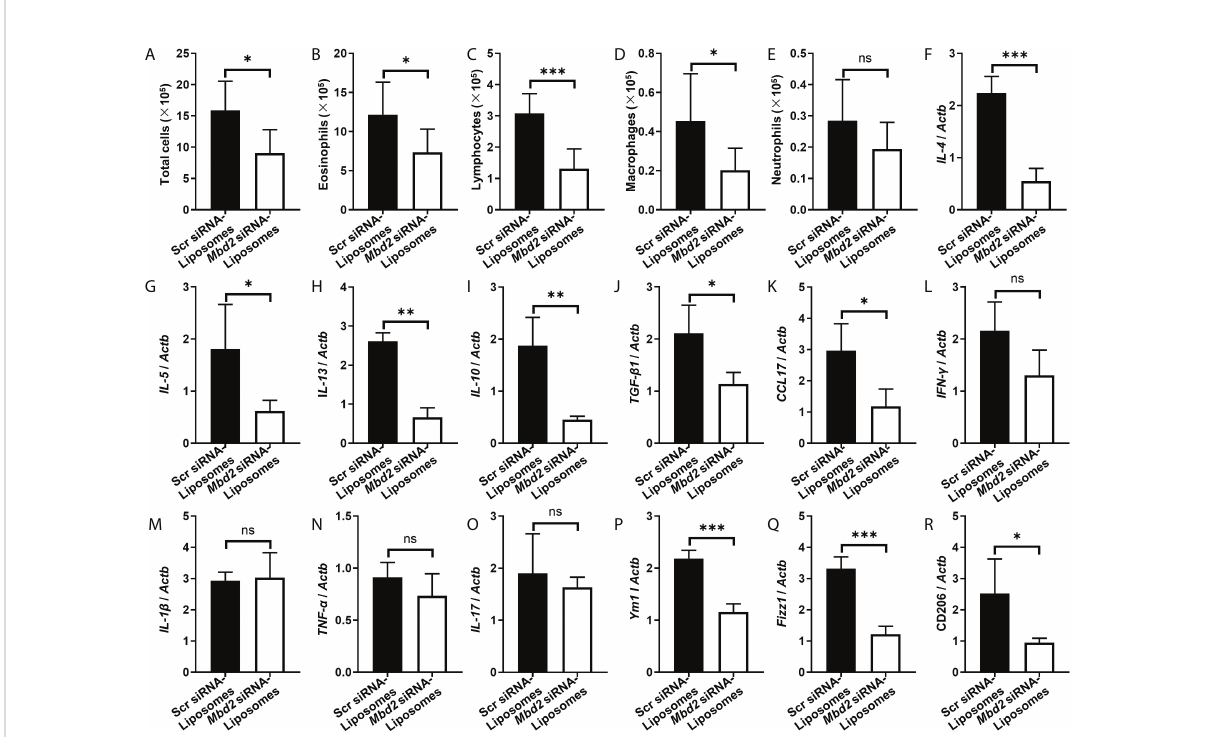
FIGURE 6 Comparison of the numbers of in fl ammatory cells and the levels of cytokines between scrambled siRNA or Mbd2 siRNA-loaded liposome- treated mice after 3 days of OVA challenge. (A – E) : Analysis of the total in fl ammatory cells (A) , eosinophils (B) , lymphocytes (C) , macrophages (D) and neutrophils (E) in BALF samples. F-O: RT-PCR analysis of the in fl ammatory mediators IL-4 (F) , IL-5 (G) , IL-13 (H) , IL-10 (I) , TGF- b 1 (J) , CCL17 (K) , IFN- g (L) , IL-1 b (M) and TNF- a (N) and IL-17 (O) in the lung samples. P-R: RT-PCR results for the analysis of Ym1 (P) , Fizz1 (Q) and CD206 (R) expression in the lung. The data were collected from studies of 4-5 mice in each study group. ns, not signi fi cant *p < 0.05; **p < 0.01; ***p <